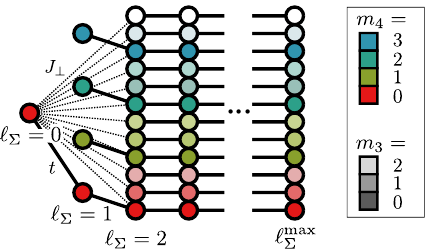
Figure 13: Truncated rotational string basis. For fixed center-of-mass momentum k of the spinon-chargon pair, we work with a truncated string basis. At string lengths ℓ = 0,1 all states are included, and labeled by their discrete C Σ mentum quantum numbers m with length ≥ 3 we only include m generally allowed matrix elements for hole (solid lines, t ) and spinon (dotted lines, J ⊥ ) hopping are indicated (in the case of the spinon, only those involving ℓ Σ = 0, for